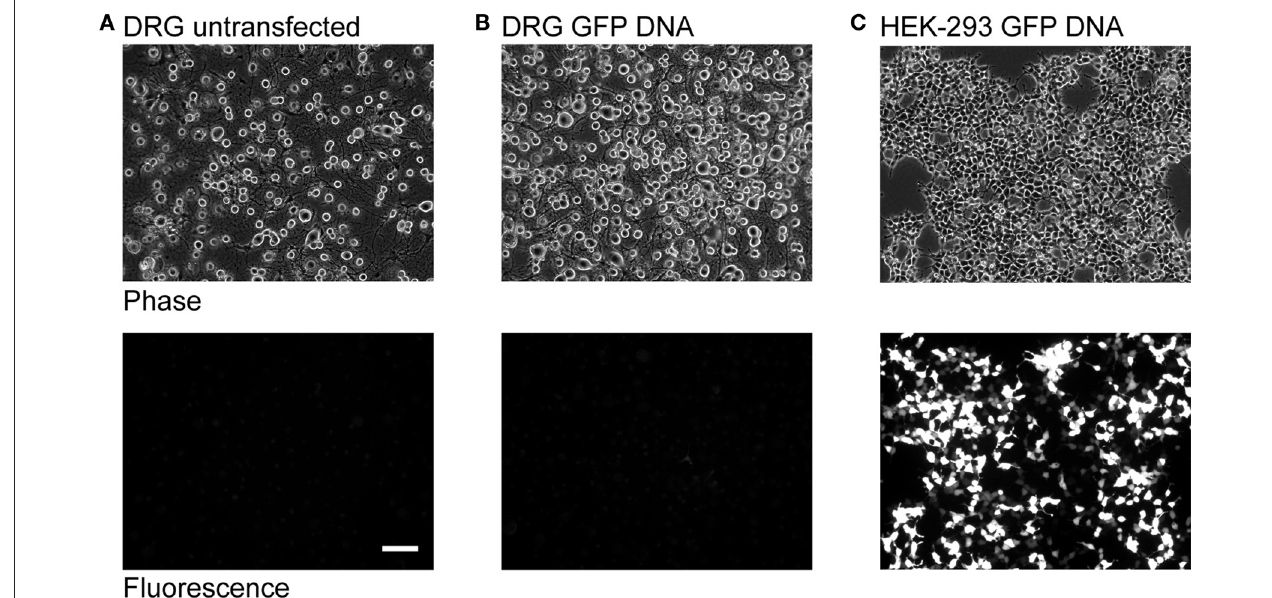
Figure S1 | Cationic lipid-mediated plasmid DNA transfection of Drg neurons. (A) Phase and fluorescence image of untransfected DRG neurons. (B) Phase and fluorescence image of DRG neurons transfected with 2 μg pEGFP-C1 DNA, 16 h after transfection (C) Phase and fluorescence image of HEK-293 cells transfected with 2 μg pEGFP-C1 DNA, 16 h after transfection. 100 μm scale bar (for all